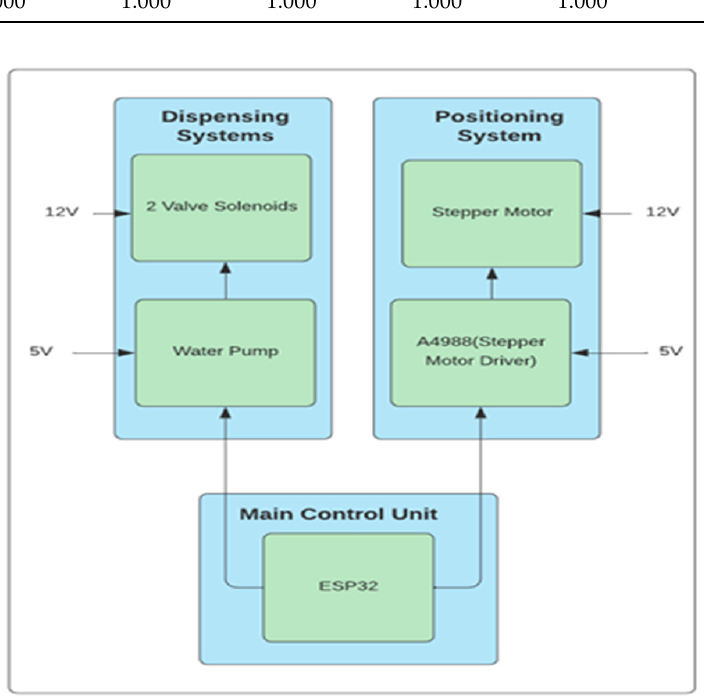
Figure 3. Schematic of the Positioning and Dispensing system of the NMS.